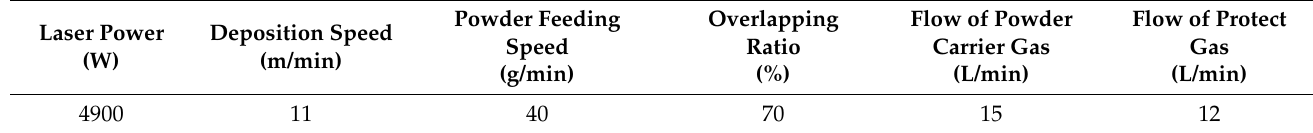
Table 2. Key process parameters of EHLA JG-11 coating.